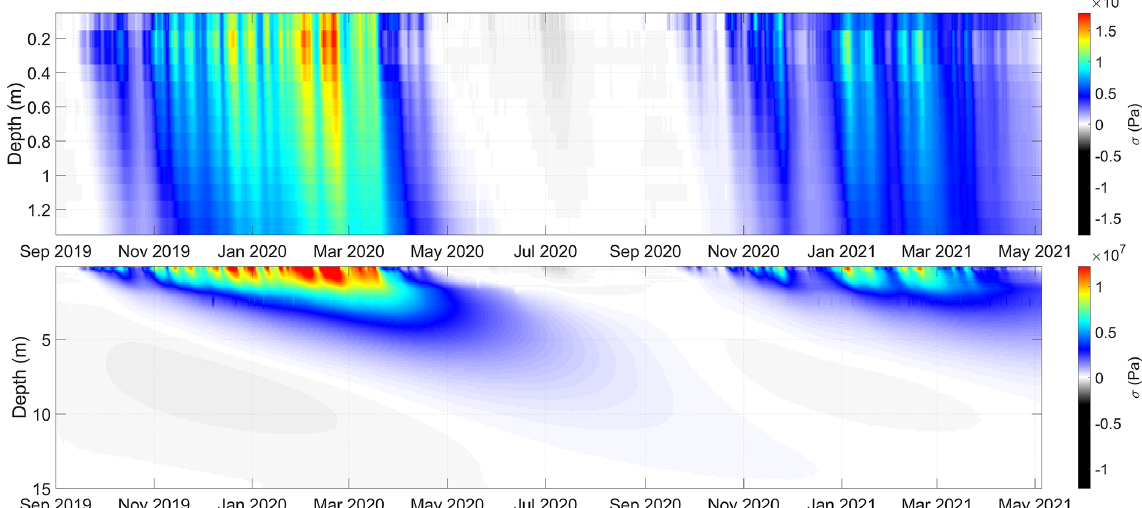
Figure 9. Illustration of the spatiotemporal thermal-stress field modeled according to Eq. (12) and constrained by temperature measurements recorded by sensors installed at Janssonhaugen Vest (0.1m) and in the P11 borehole (0.2–15m). The temperature–depth profile used to calculate thermal stress was interpolated to regular 10cm intervals using a spline interpolant. Sign convention is positive for tensional stress.